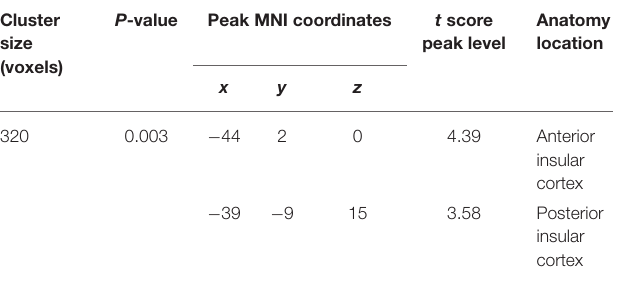
TABLE 3 | VBM analysis for IDH-mu >